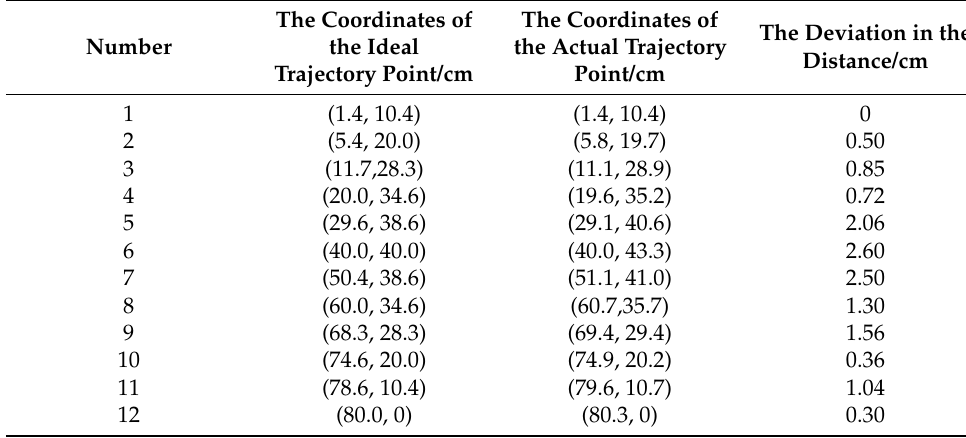
Table 2. Experiment data of steering in the